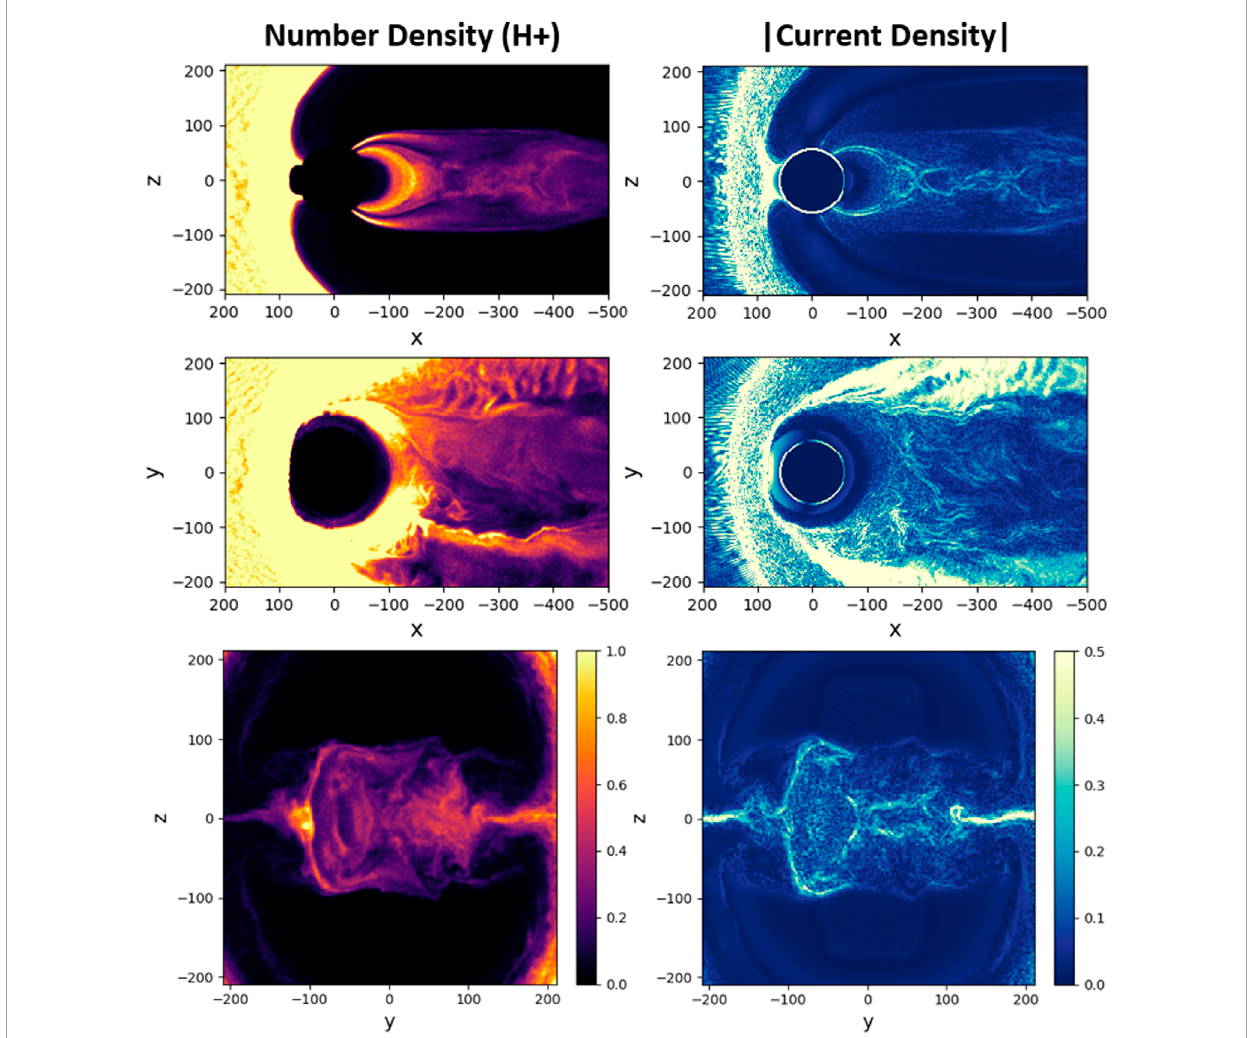
FIGURE 3 H+ number and absolute value of net current density, | J | in three cross-sections in the first lobe outflow simulation at Ω cp t = 461: x–z ( y = 1 d i ) , x–y ( z = 1 d i ) , and y–z ( x = − 199 d i )